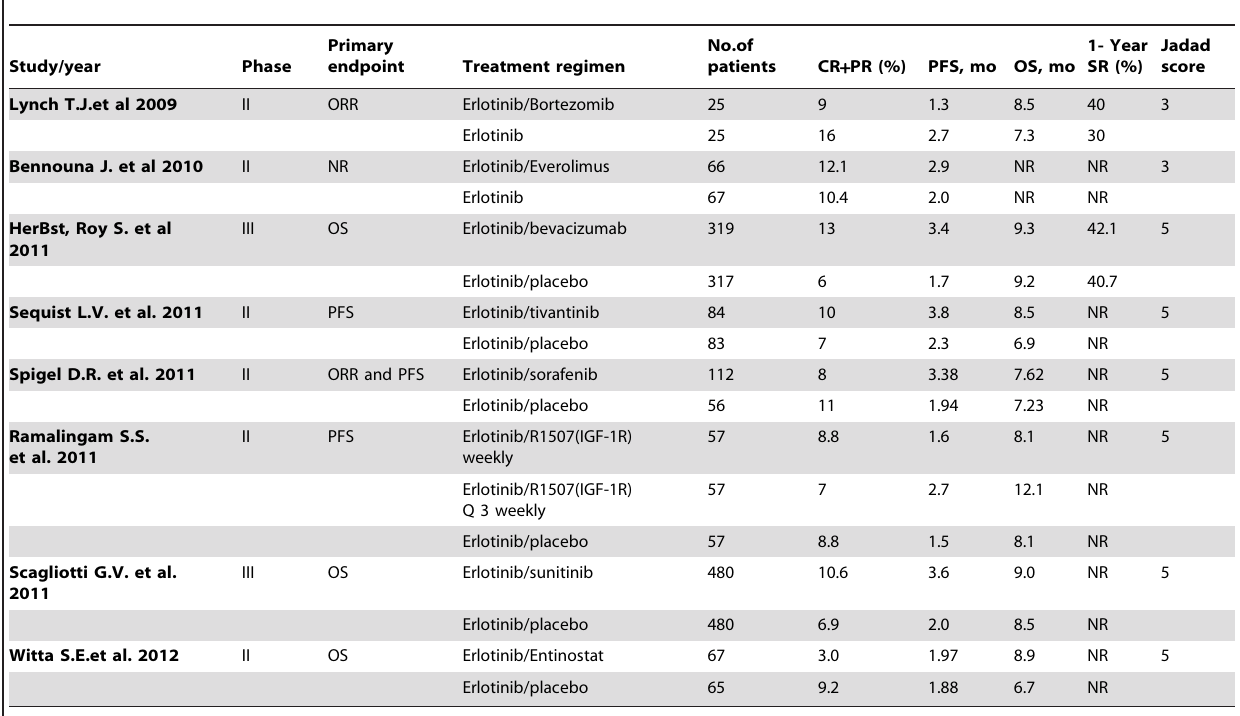
Table 1. overview of studies in the pooled analysis (N